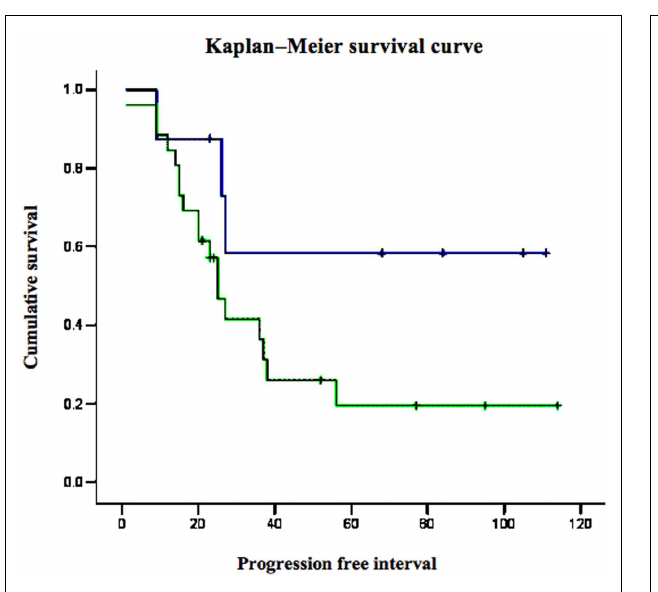
FIGURE 3 | Kaplan–Meier survival curve for p53-overexpressing and non-expressing tumors in women with USC .